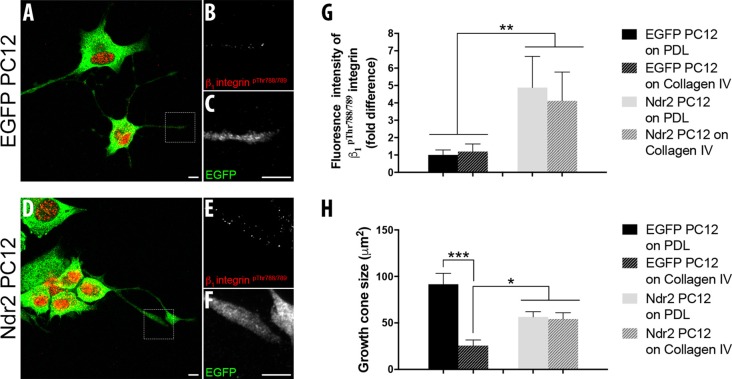
Ndr2 increases the expression of activated β1 integrins at neurite tips regardless of the extracellular matrix (ECM) substrate. Immunocytochemistry of differentiating EGFP PC12 cells (A–C) and Ndr2 PC12 cells (D–F). A closer look into the growth cones of Ndr2 PC12 cells reveals the co-localization of activated β1 integrin (pThr788/789) (E) and Ndr2 (F) at neurite tips. Scale bars: 10 μm. (G) Quantitative analysis of fluorescence intensity (n = 10 cells per group) reveals a significant accumulation of activated β1 integrin (pThr788/789) in neurite tips of differentiating Ndr2 PC12 cells compared to EGFP PC12 cells, both on PDL and collagen IV (two-way ANOVA genotype effect: F(1,36)= 7.407, p < 0.01). (H) Decreased growth cone size of control cells, but not of Ndr2 PC12 cells on collagen IV substrate (two-way ANOVA genotype × substrate interaction: F(1,35) = 15.67, p = 0.0004). Values are mean + SEM; *p < 0.05; **p < 0.01; ***p < 0.001.